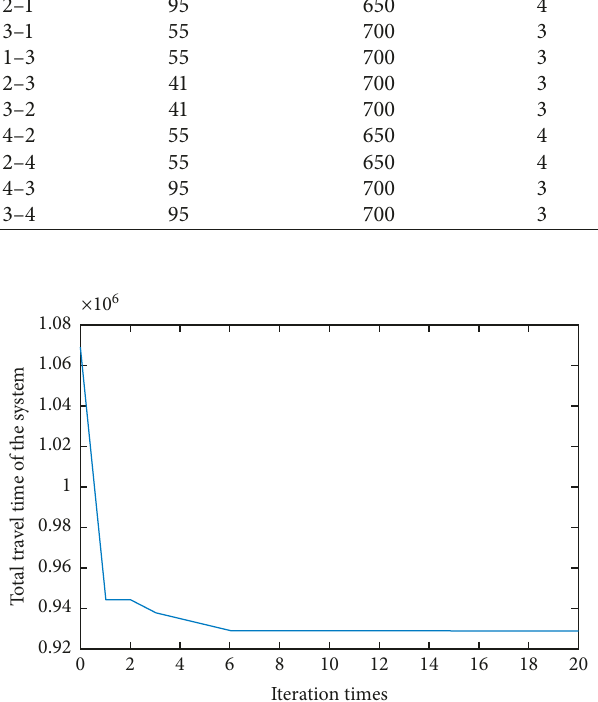
Figure 2: Total travel time of the system changes with iteration